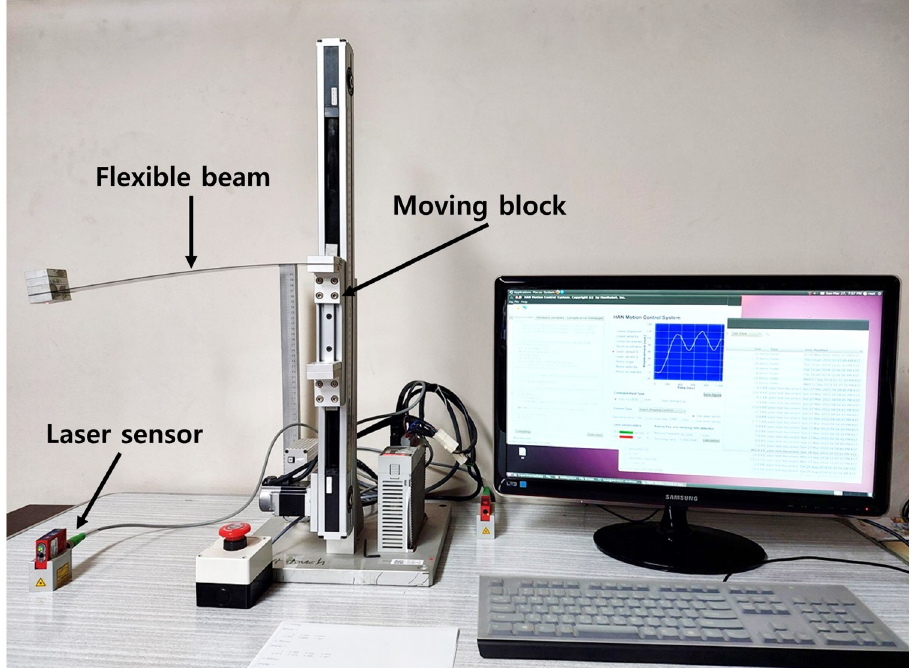
Fig 9. Horizontal beam vibration apparatus. The apparatus can generate vertical movements with a flexible horizontal cantilever beam with added masses at the end. The system has natural frequency ω ratio z of